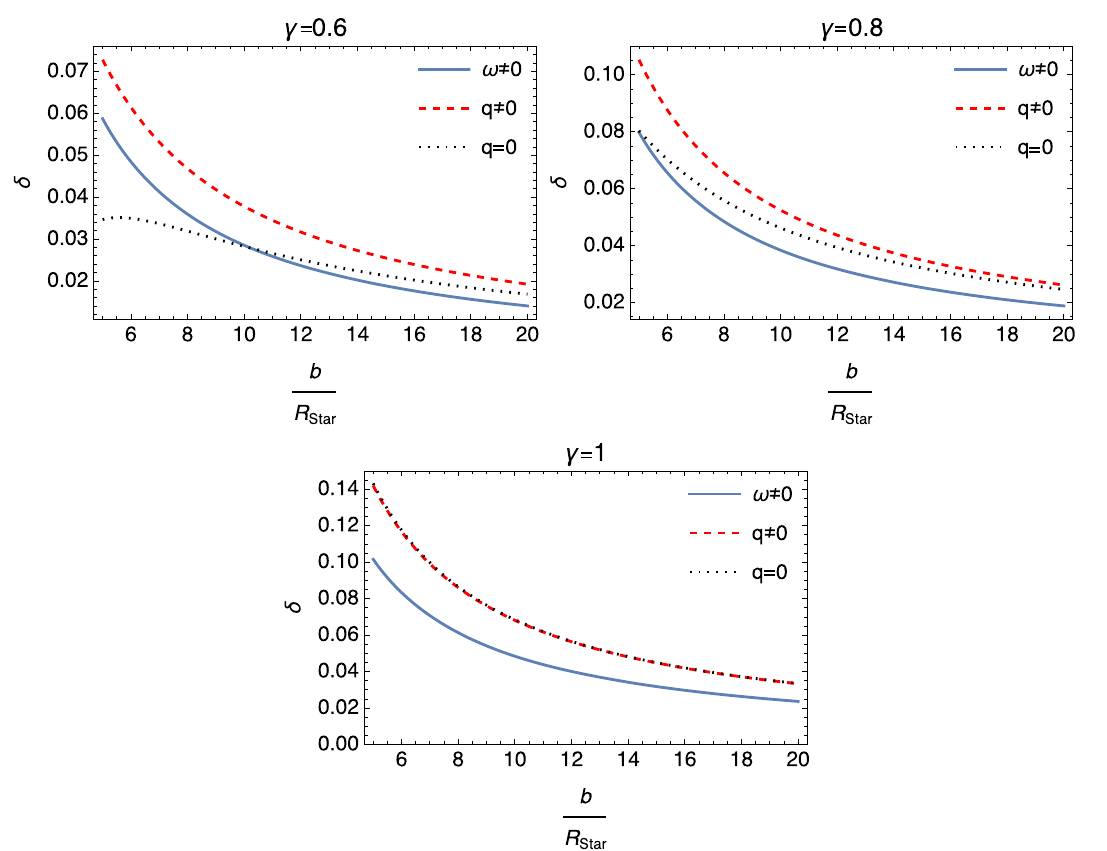
( q = 0 ) . Variation for each case are shown on the same graph for different values of deformation parameter